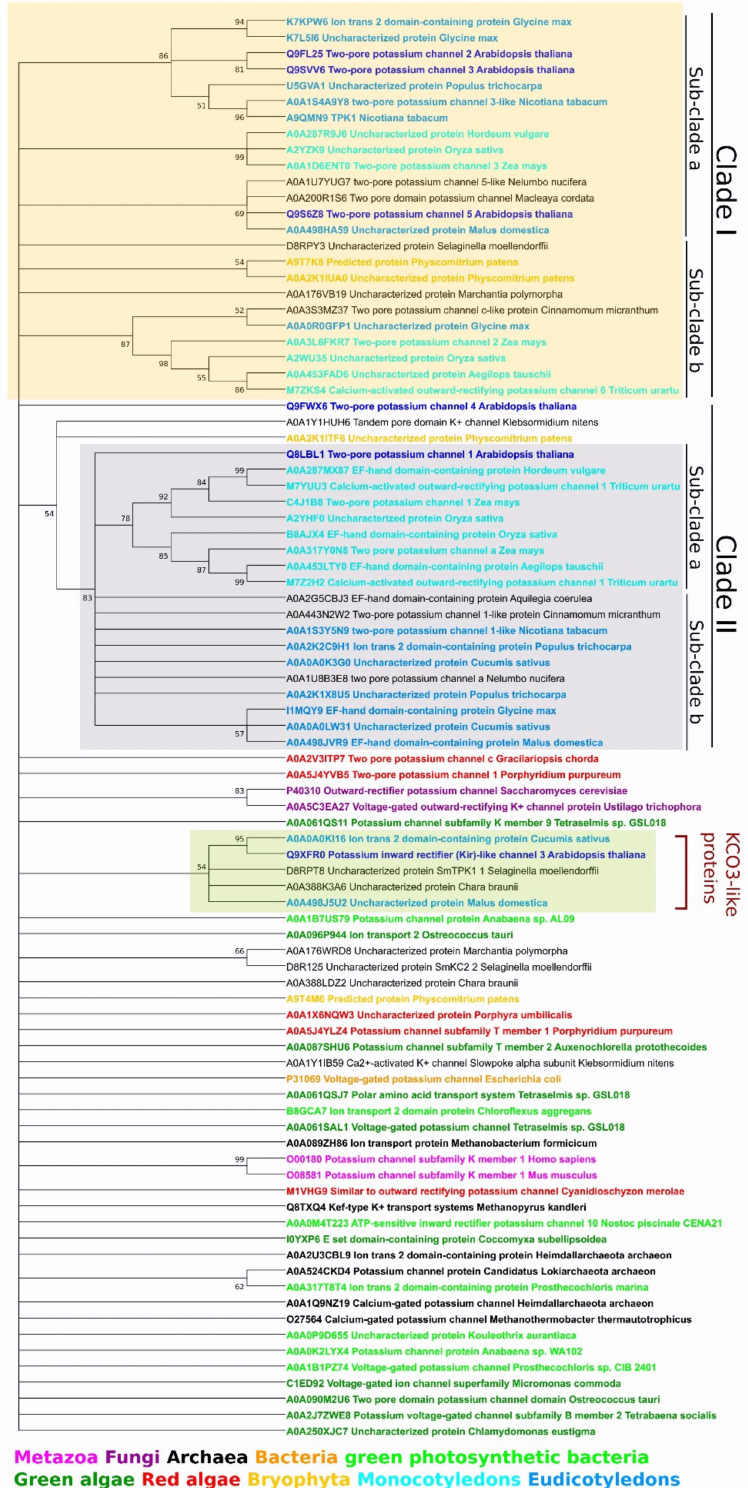
Figure 4. Phylogeny estimation of the TPK proteins. Full-length proteins from selected taxa were used for phylogeny reconstruction with the maximum likelihood method and LG substitution model. Previously conducted TPK channel phylogeny analyses have had some limitations. For example, Voelker et al. (2010) [19] only used 12 plant species (“low” plants, mono- and dicotyledons); Gomez-Porras et al. (2012) [34] only used five plant species;